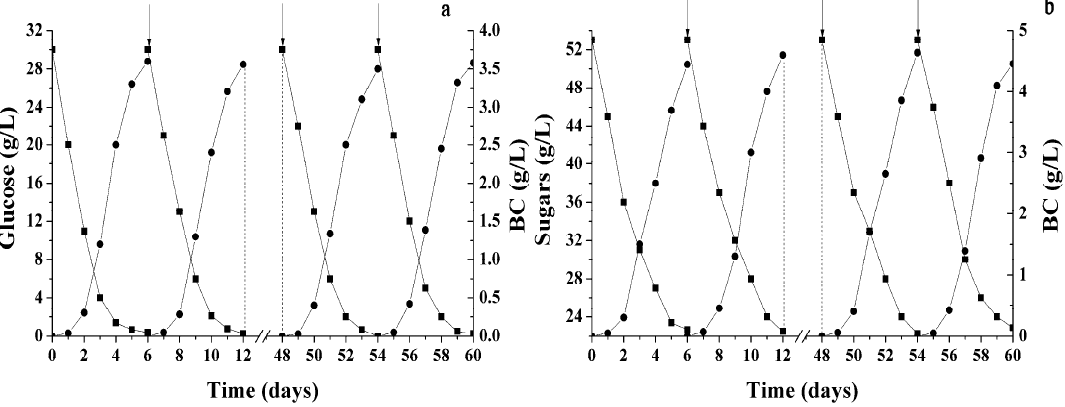
Figure 6. The sugars consumption ( ) and BC accumulation ( ) during the repeated use of Komagataeibacter xylinum B ‐ 12429 immobilized cells (9.5 CDW g/L) under static conditions. The broken lines and the arrows indicate the time when the culture broth was substituted with a fresh medium: containing glucose ( a ) or hydrolysate of Jerusalem artichoke ( b ).